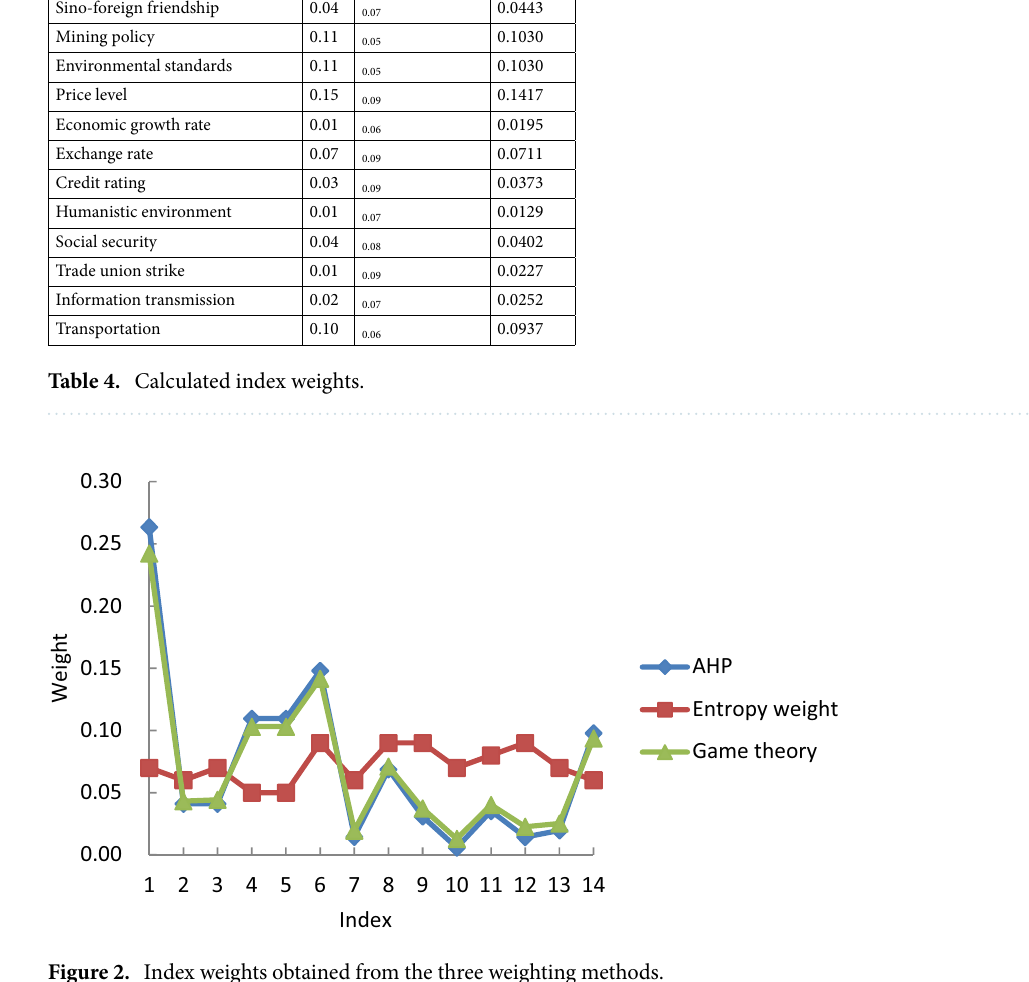
Figure 2. Index weights obtained from the three weighting